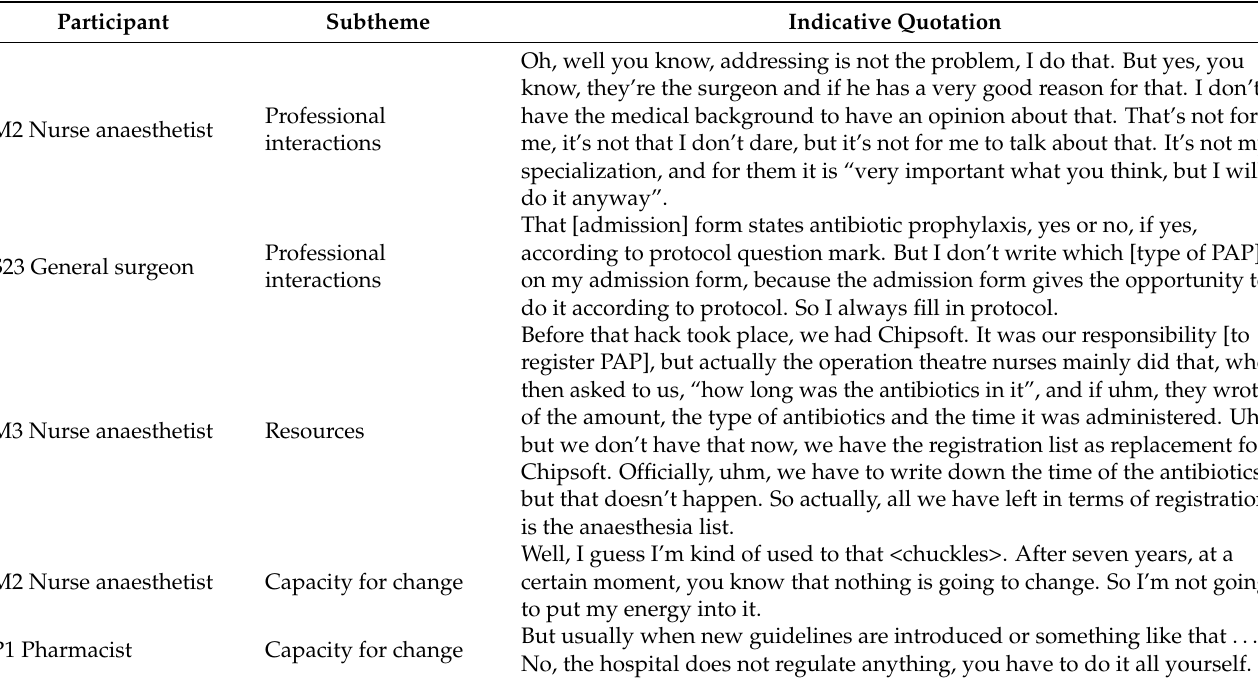
Table 4. Hospital factors: indicative